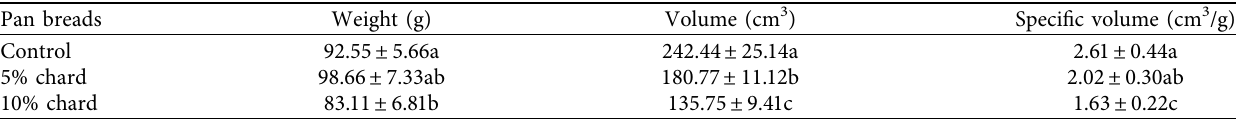
Table 6: Physical properties of pan breads fortified with 5% chard and 10% chard compared with those of the control pan bread.